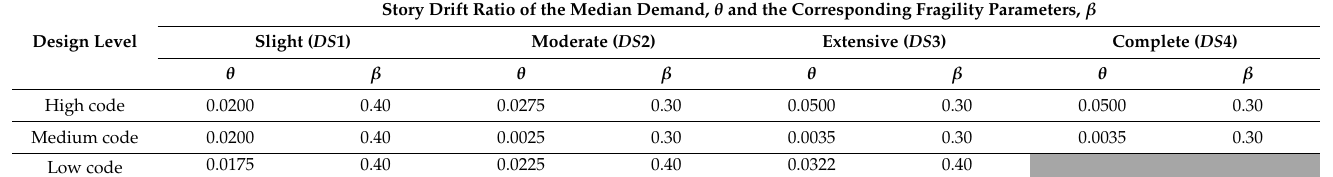
Table 2. The damage limit state for RC frame according to FEMA P-58